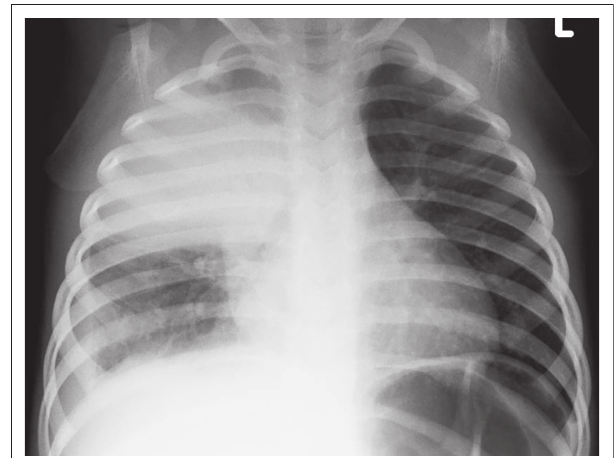
FIGURE 4: Young girl with HIV infection and TB infection. Frontal chest radiograph shows right upper lobe consolidation.